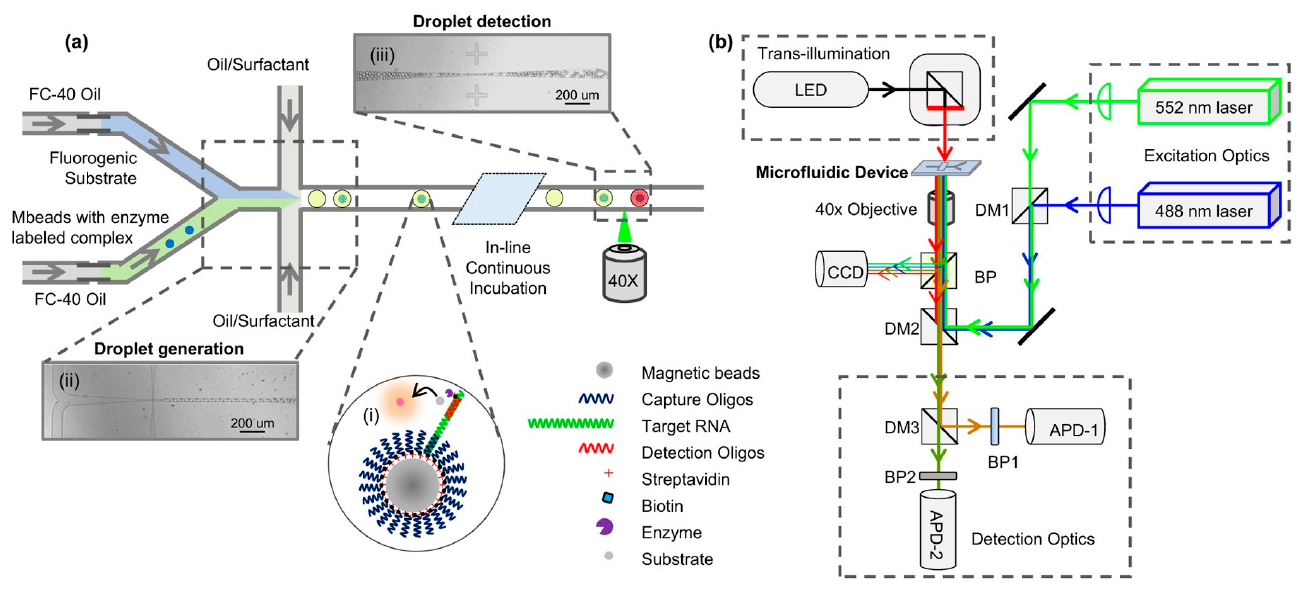
Figure 1. Transillumination imaging of a microfluidic device. Panel ( a ) represents a schematic of the microfluidic device used by Guan et al. Panel ( b ) demonstrates the traditional setup of transillumination imaging where the LED is used as the light source and a microscopic objective lens and a CCD detector on the other side of the microfluidic device that is being imaged. Reproduced from [19] under Creative Commons Attribution 4.0 License.